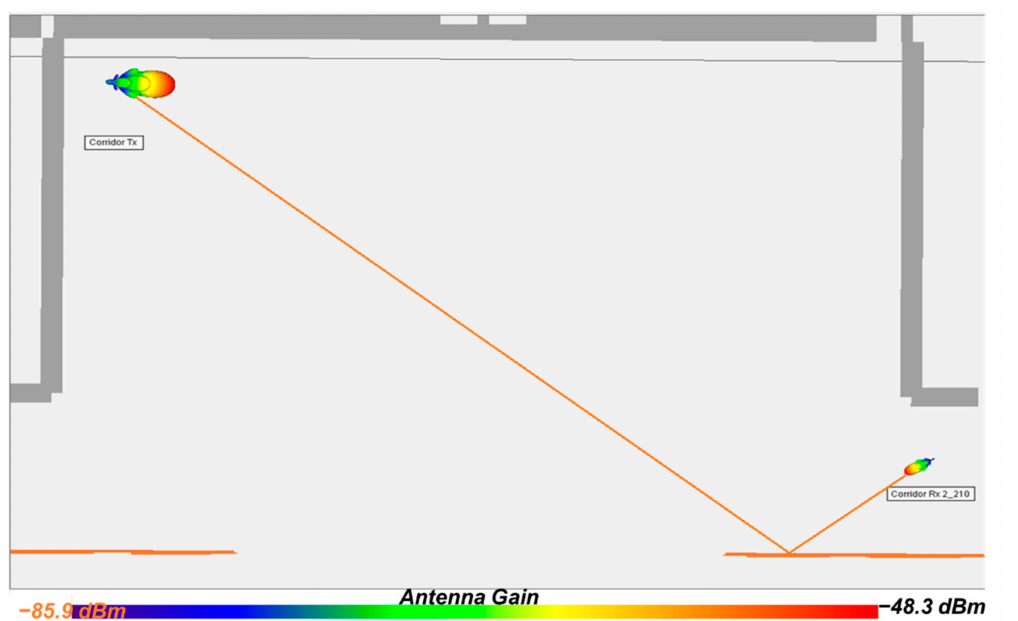
Figure 13. Reflection from the wooden wall (strongest paths for all Rx2 (210 – 250°)).